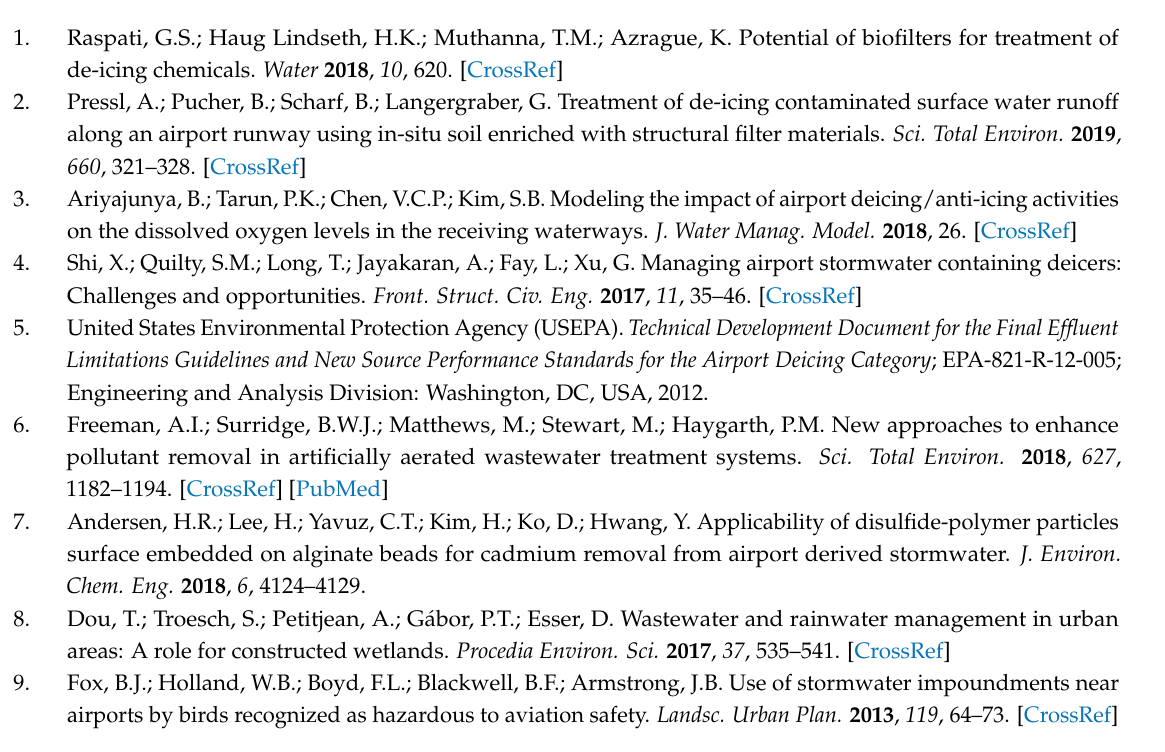
Table S1. Composition of model wastewater. Table S2. Dependent variable: nitrification efficiency, qualitative Table S4. Dependent variable: efficiency of nitrogen compounds removal, qualitative variable: temperature. Table S5. Dependent variable: efficiency of nitrogen compounds removal, qualitative variable: ratio C/N. Table S6. Dependent variable: concentration of removed nitrogen as a result of denitrification, qualitative variable: temperature. Table S7. Dependent variable: concentration of removed nitrogen as a results of biomass synthesis, qualitative variable: temperature. Table S8. Dependent variable: efficiency of organic compounds removal, qualitative variable: temperature. Table S9. Dependent variable: efficiency of organic compounds removal, qualitative variable: ratio C/N. Table S10. Dependent variable: concentration of organic compounds in treated wastewater, qualitative variable: ratio C/N. Table S11. Nitrification and denitrification efficiencies and processes in different bioreactor configurations under the conditions